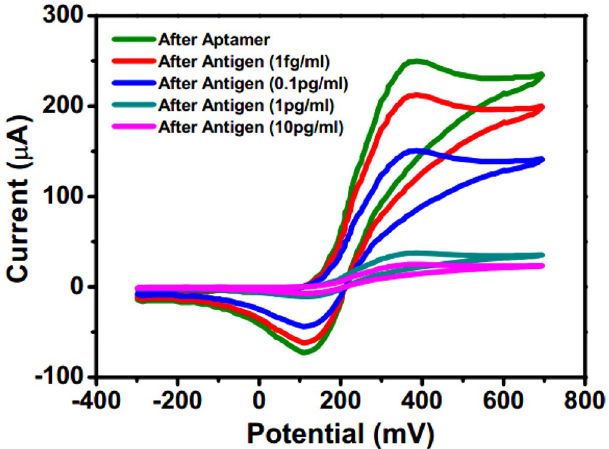
Figure 2. Cyclic voltammetry in presence of external electric field after aptamer and antigen binding (graph indicates mean values with maximum standard deviations of ± 6%).